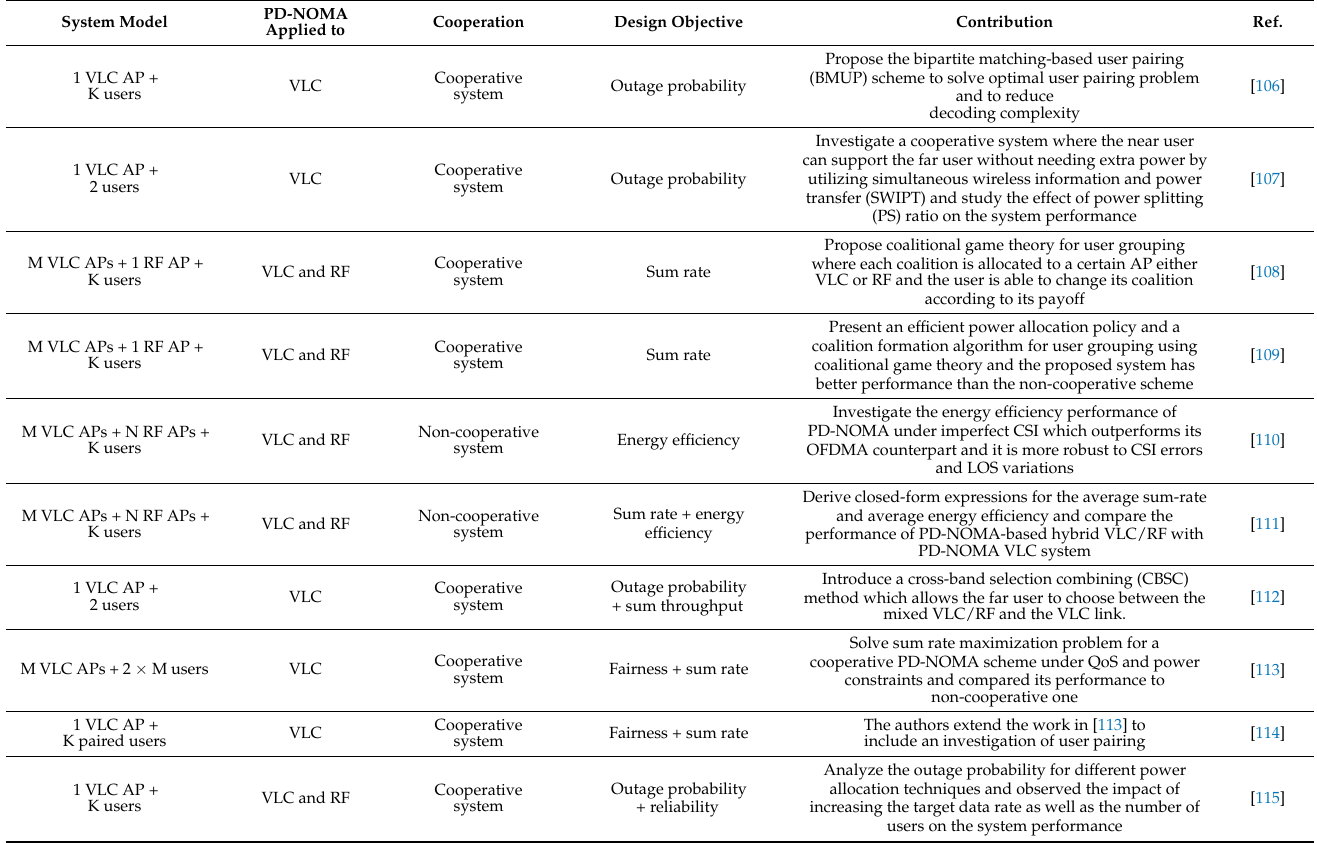
Table 4. A summary of PD-NOMA-based hybrid VLC/RF